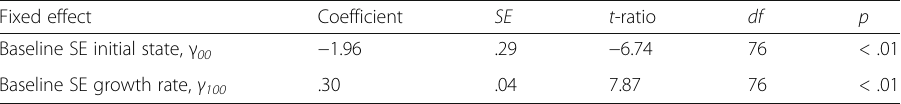
Table 4 Estimation of Baseline for Initial Status and Growth Rate in SE